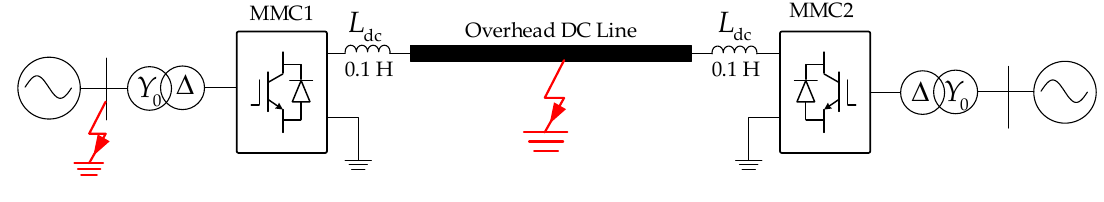
( d ) Figure 8. The Thévenin equivalent circuit for full states: ( a ) Thévenin equivalent circuit; ( b ) Steady state; ( c ) Positive current at blocked state; ( d ) Negative current at blocked state.